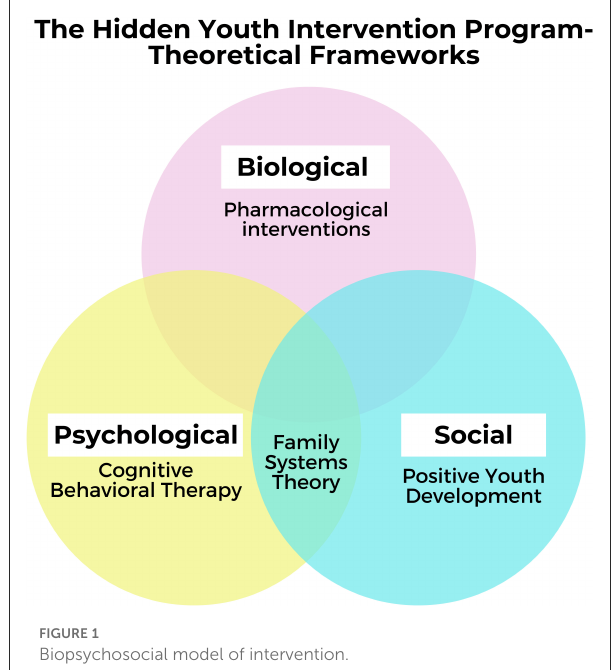
FIGURE1 Biopsychosocial model of